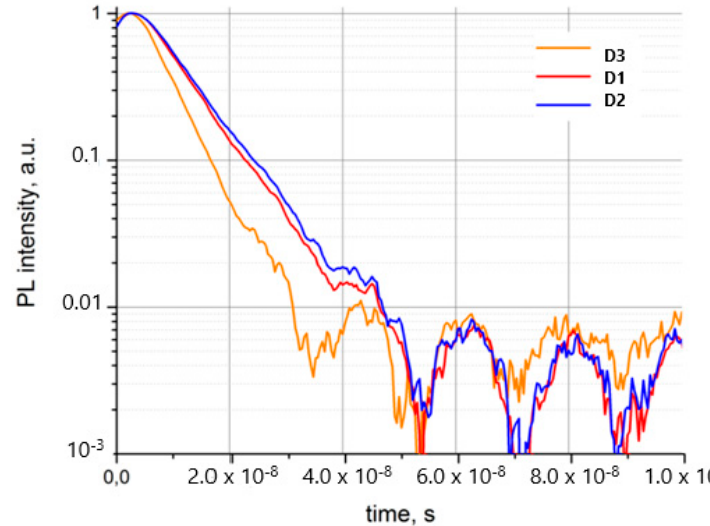
Figure 3. Photoluminescence decay curves of D1 , D2 , D3 in semilogarithmic scale. λ ex = 355 nm, λ em = 550 nm.